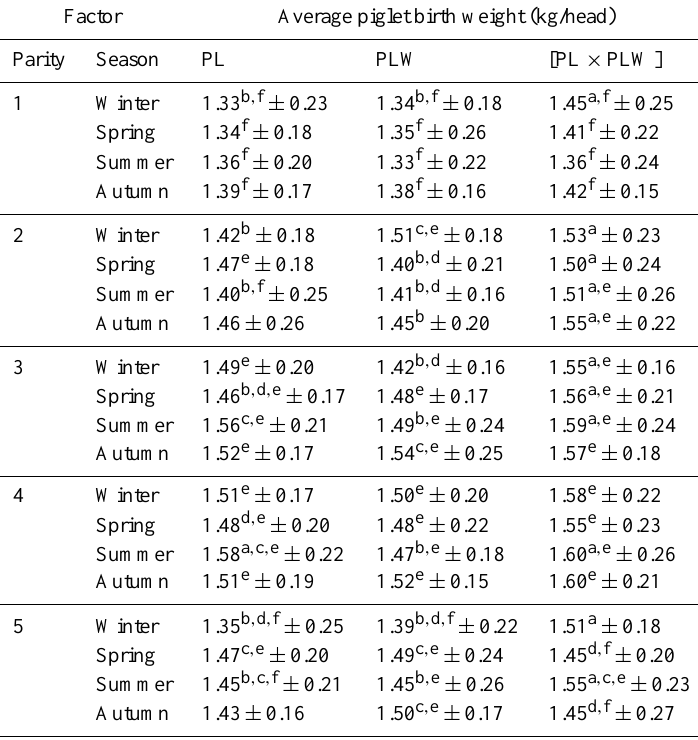
Table 4. The impact of season, parity and breed on average piglet birth weight.